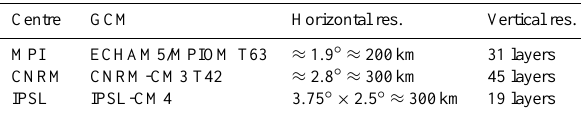
Table 1. Three IPCC AR4 GCMs and their properties. Centre GCM Horizontal res. Vertical res. MPI ECHAM5/MPIOM T63 ≈ 1 . 9 ◦ ≈ 200km